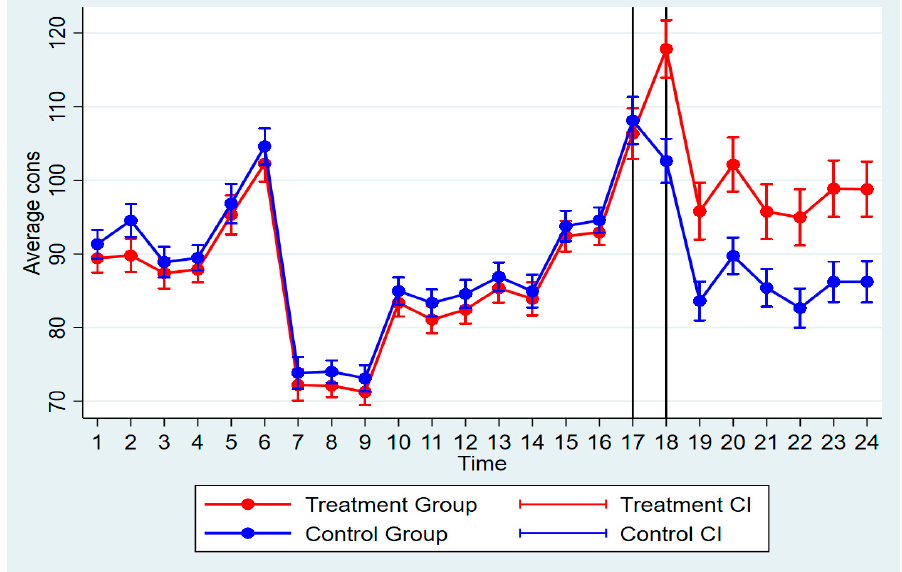
Figure 2. Average consumption pattern (kWh/month) for both the treatment and control